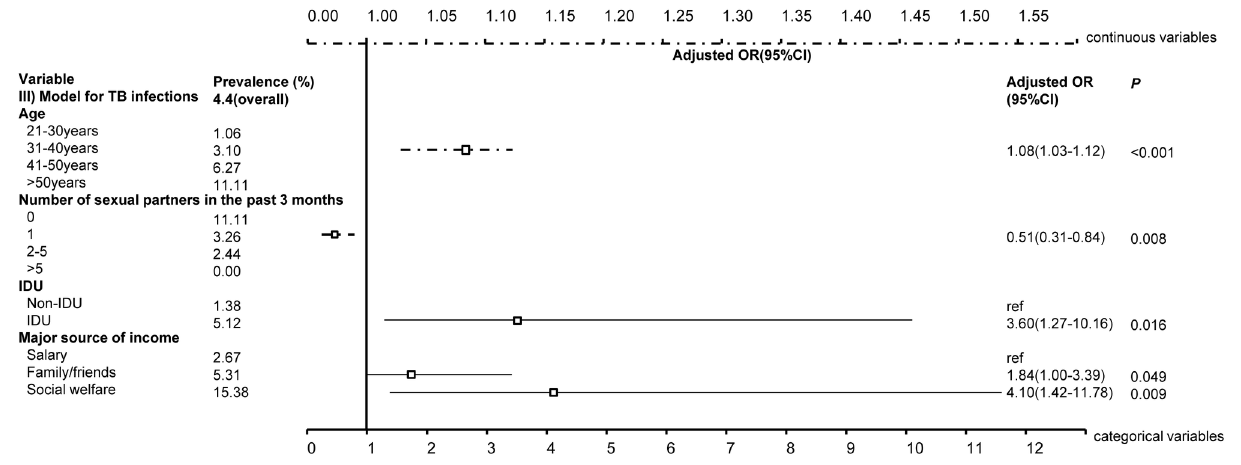
Figure 3. Significant associated factors for TB infections among MMT entrants by multivariate regression analysis. The figure demonstrates the adjusted odds ratios (together with 95% confidence intervals) of factors that are significant associated with TB infections among MMT entrants. The top dashed line denotes the scale for the continuous variables, whereas the bottom solid line denotes that for categorical